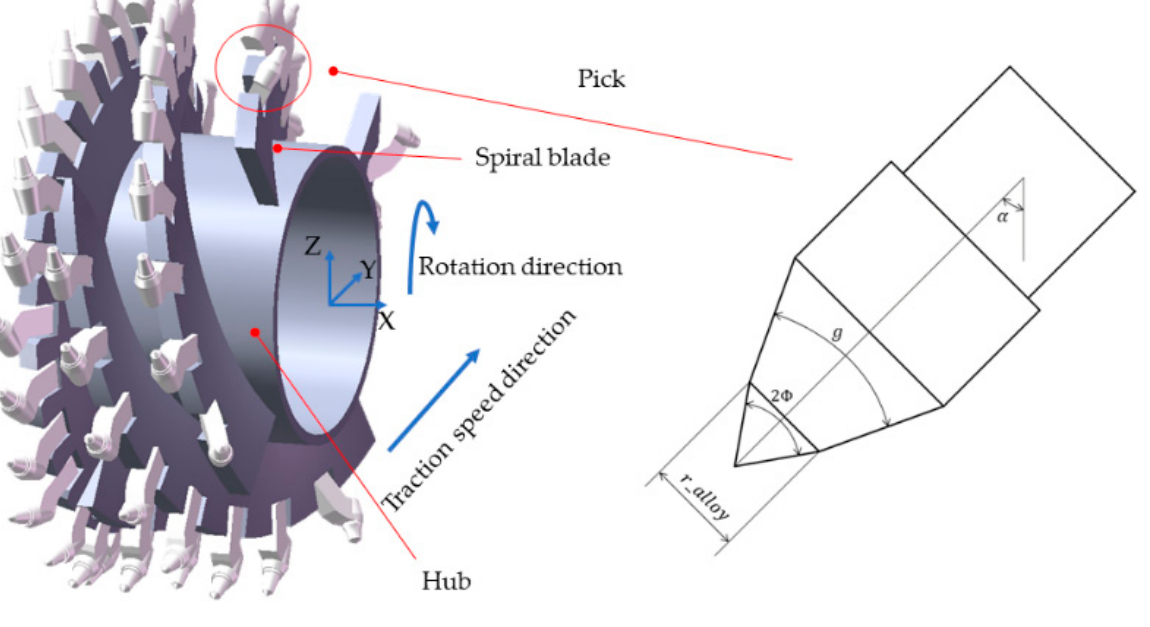
Figure 1. Design variables of the drum and pick.